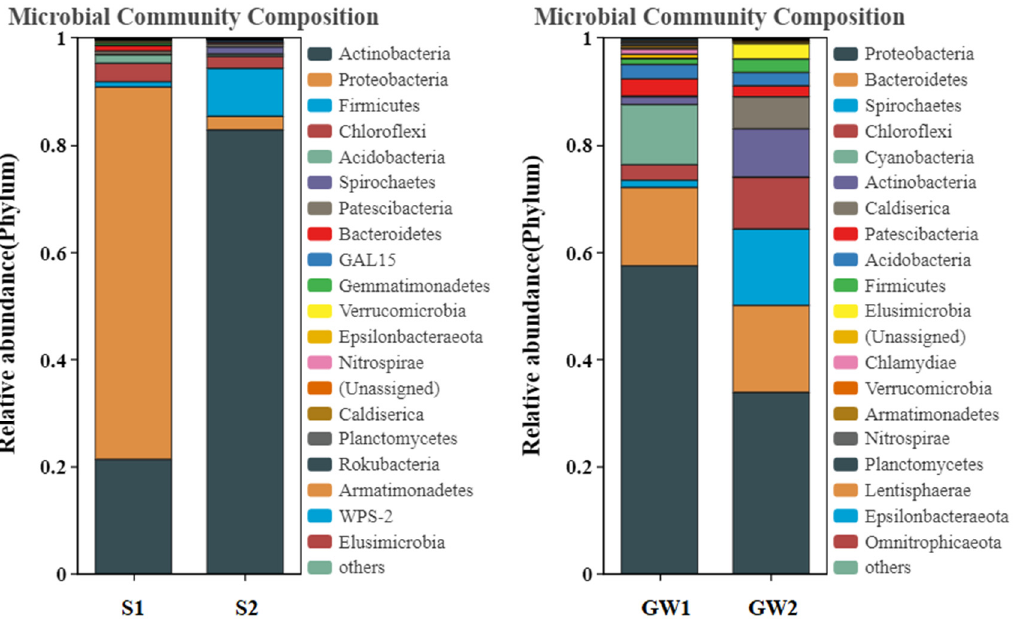
Figure 2. Comparisons of bacterial community structures at phylum level for the samples (S indi- cates soil, and GW indicates groundwater).